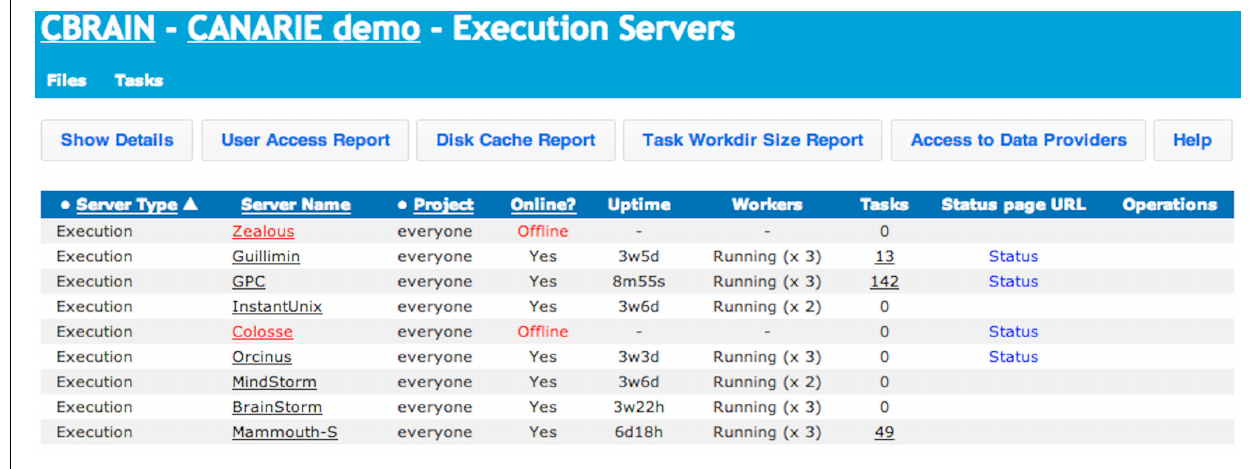
FIGURE 5 | CBRAIN portal: execution servers view. This view allows users to see which computing resources are available for his/her use and their real-time status. Users can also obtain reports on tool access, cache